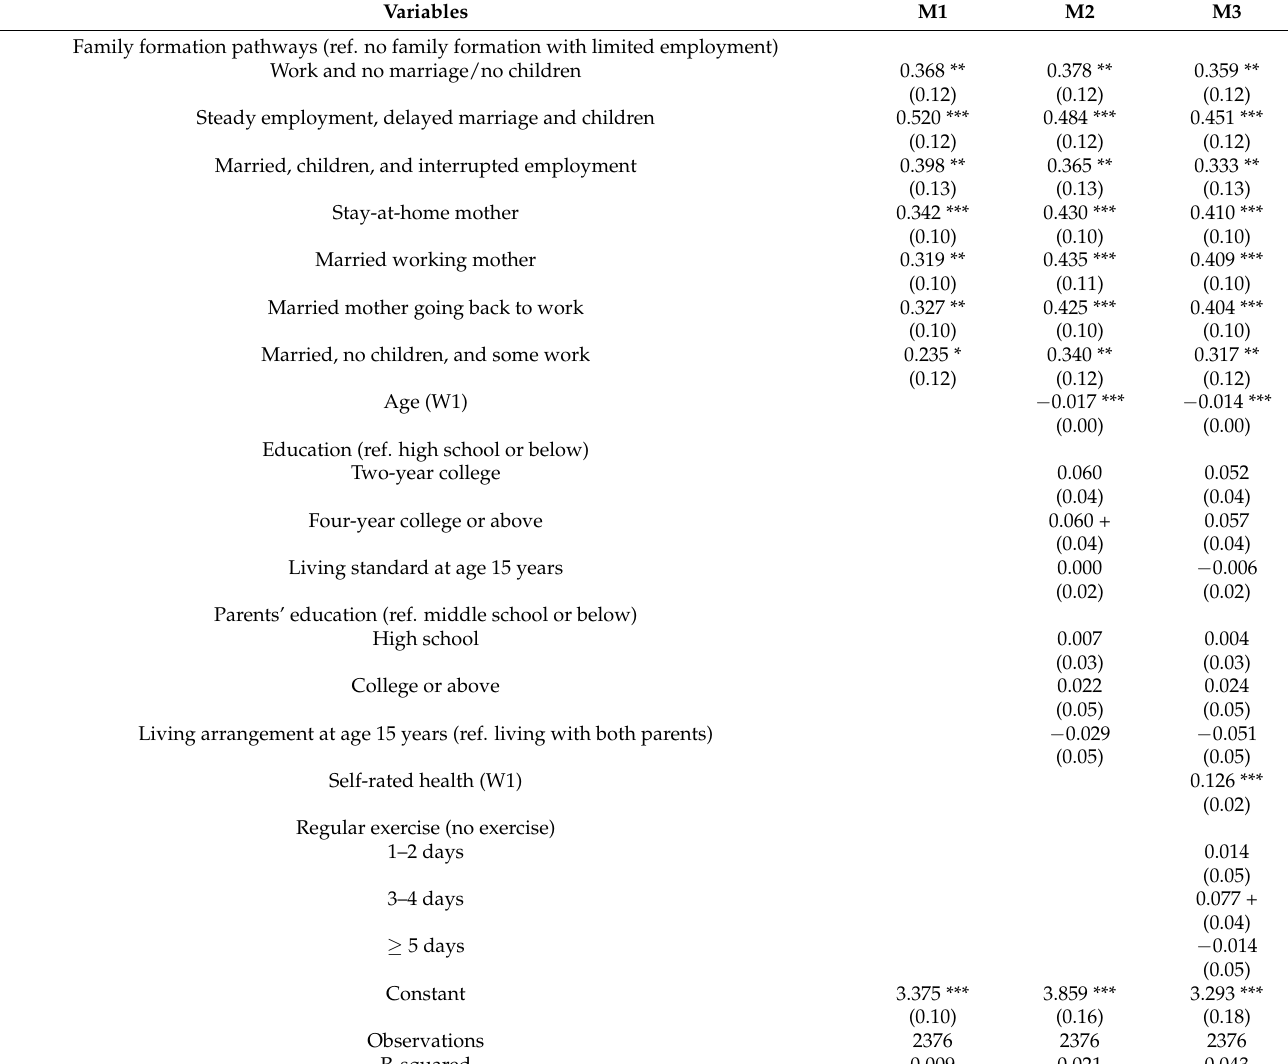
Table 3. OLS regression analyses of latent class membership estimating self-rated